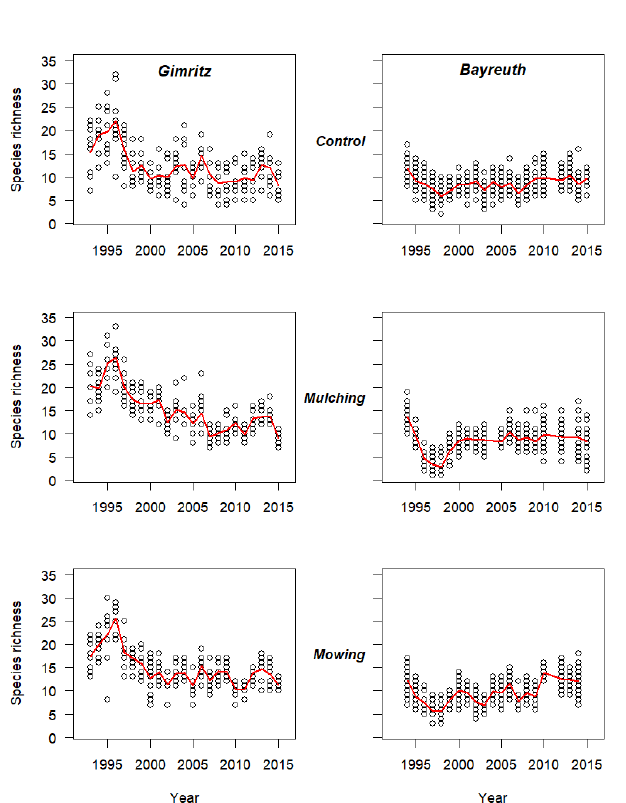
Figure 1. Species richness of subplots within each treatment plot- ted versus years for the study sites Gimritz and Bayreuth (see also Table 2). The red shows the mean across